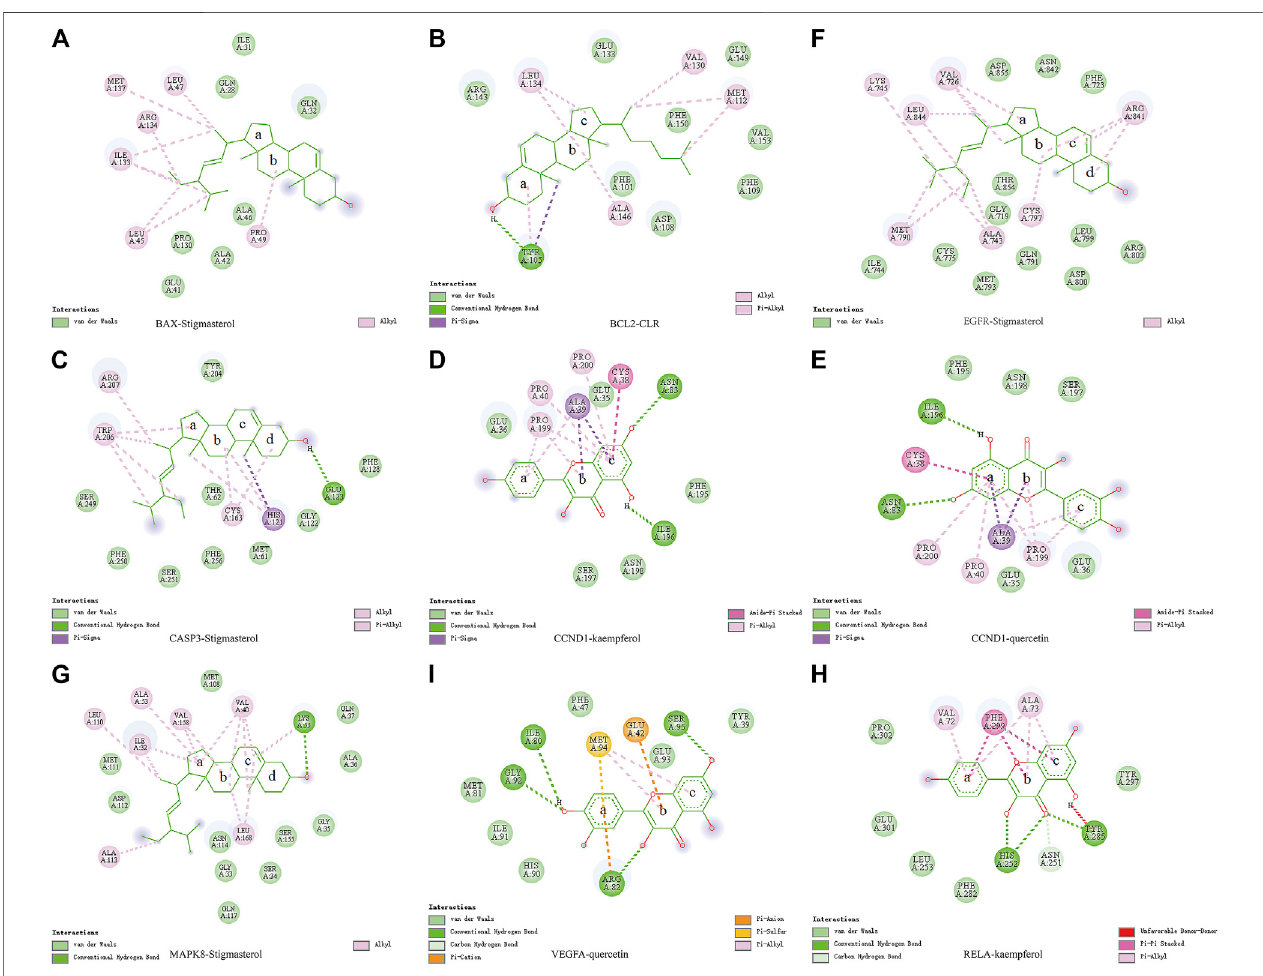
FIGURE6| Bindingof PM compoundsininteractionwithtargetproteins.Thebingdingmodeof PM compounds,includingstigmasterol,CLR,kaempferol,and quercetin in the proteins (A) BAX, (B) BCL2, (C) CASP3, (D,E) CCND1, (F) EGFR, (G) MAPK8, (H) RELA, and (I) VEGFA.